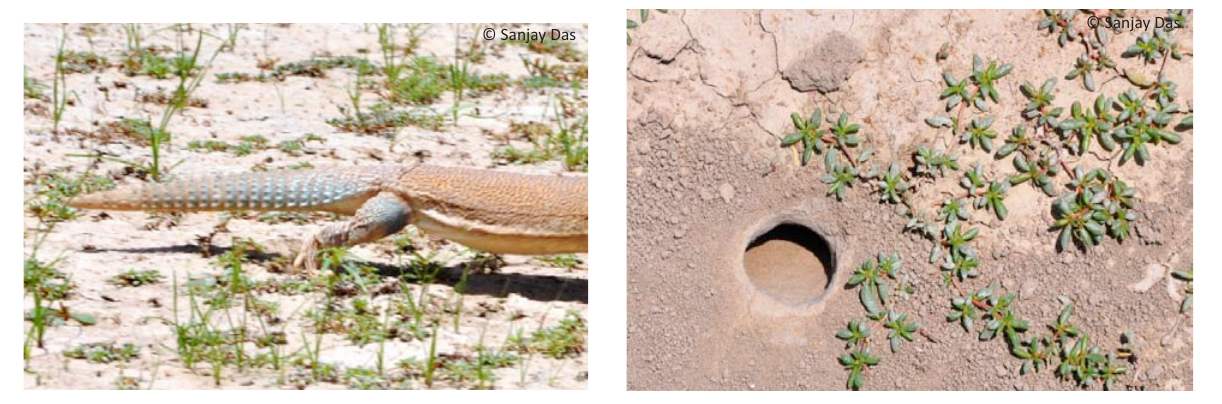
Image 13. Blue tinge along the tail and thigh region Image 14. Portulaca